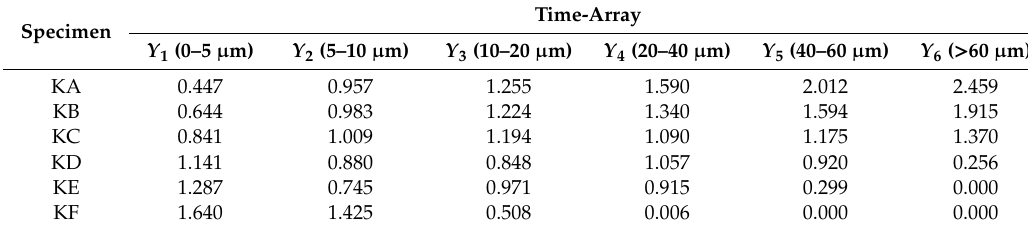
Table 6. Time ranges of sub-array.